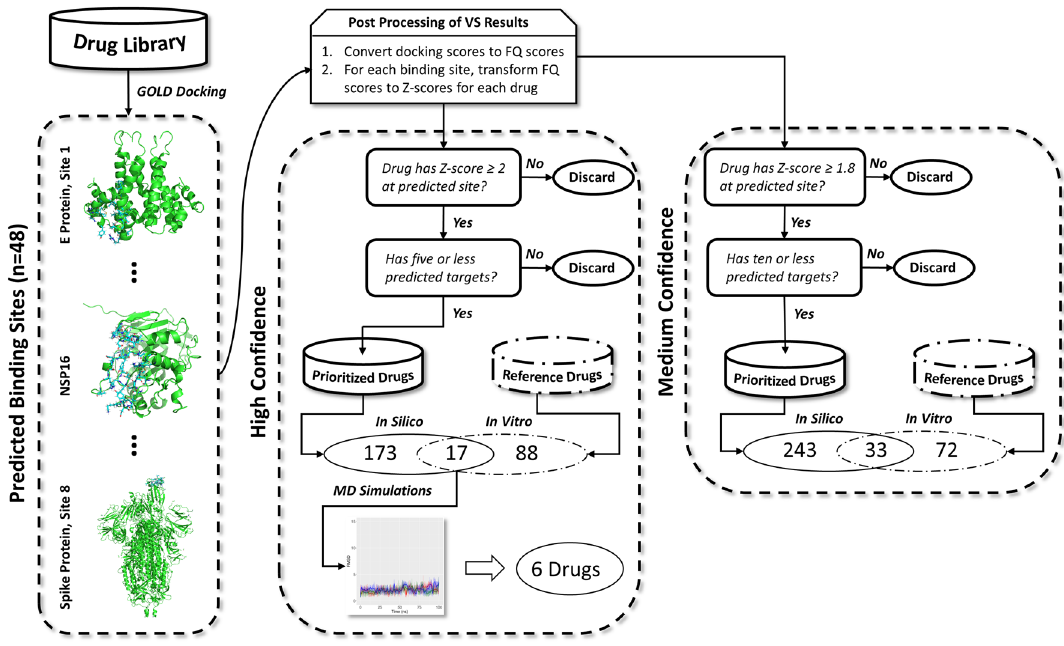
Figure 2. Pipeline for docking-based, “two-way” virtual screening strategy. GOLD software was used to dock the drug library against each of the 48 predicted binding sites. All docking scores were converted to fit quality (FQ) scores. Subsequently, the FQ scores of each drug were transformed into Z scores for each site. Out of the 1,268 FDA-approved drugs, 190 were prioritized with a Z score ≥ 2 at 5 or fewer target sites; these were considered high confidence hits. Consequently, 17 overlapped with a set of drugs previously known to have marginal to high potency against SARS-CoV-2 in vitro and were considered virtual hits 10 . These were then subjected to MD simulations, in which 6 drugs were observed to bind stably to their respective target protein. A medium confidence set of drugs was also prepared based on a Z score ≥ 1.8, which prioritized 276 drugs; 33 of these overlapped with the reference drugs. Overall, there were 34 and 97 unique drug-site pairs for the high- and medium confidence hits respectively that overlapped with the reference drugs. In-silico, prioritized drugs are shown in cylinders with solid lines and reference drugs with in vitro activity against SARS-CoV-2 in cylinders with dashed-dotted lines. Prepared using PowerPoint Presentation